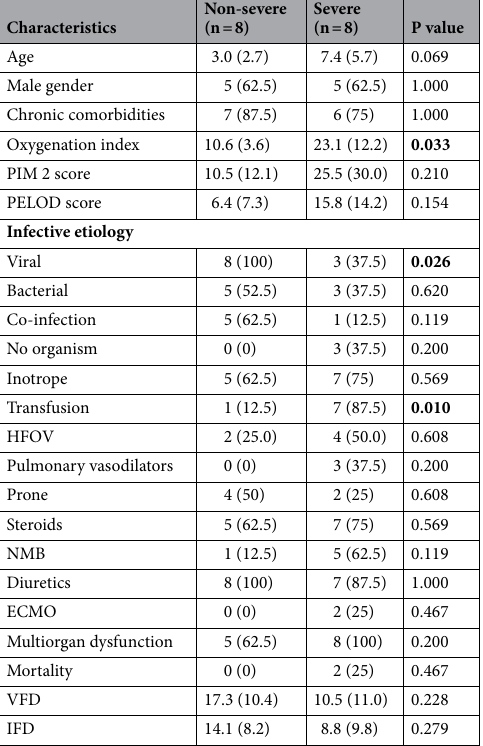
Table 1. Clinical characteristics of patients in the non-severe and severe groups. Bold values signify p < 0.05. Categorical and continuous data are presented as counts (percentages) and mean (standard deviation) respectively. PIM 2 Pediatric Index of Mortality, PELOD Pediatric Logistic Organ Dysfunction, HFOV high frequency oscillatory ventilation, NMB neuromuscular blockade, ECMO extracorporeal membrane oxygenation, VFD ventilator free days, IFD intensive care unit free